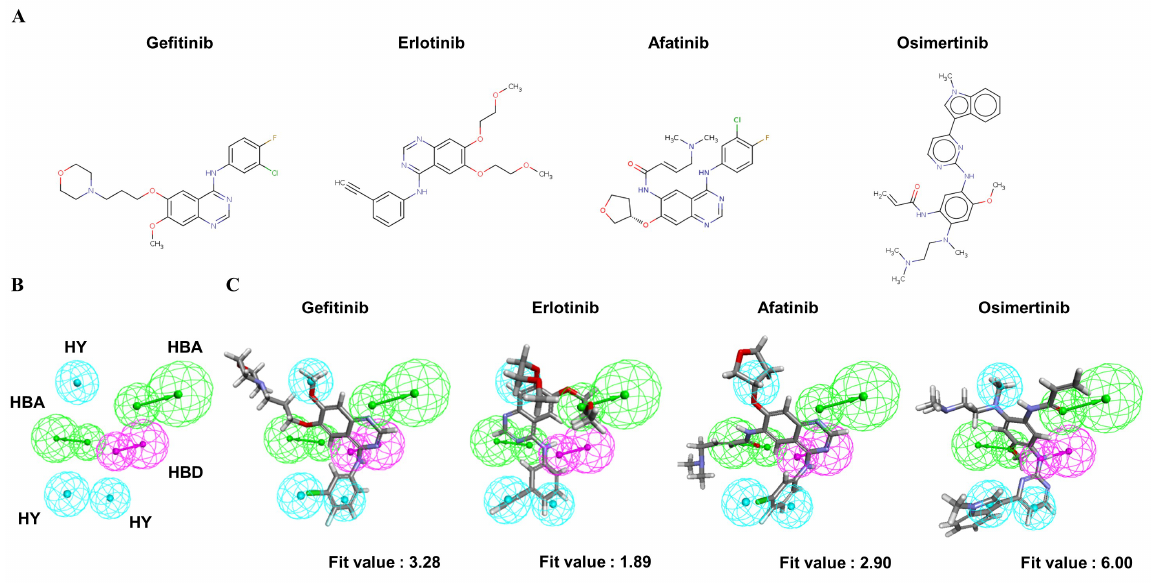
Figure 3. The common feature pharmacophore model of clinical EGFR inhibitors. ( A ) Structures of four clinically approved EGFR inhibitors. Gefitinib, erlotinib, and afatinib are 4-anilinoquinazoline derivatives. Osimertinib is a mono-anilino-pyrimidine derivative. ( B ) Pharmacophore features of the Pharm2 model: hydrogen bond acceptor (HBA, green), hydrogen bond donor (HBD, purple), and hydrophobic region (HY, blue). ( C ) Mapping of gefitinib (fit value = 3.28), erlotinib (fit value = 1.89), afatinib (fit value = 2.90), and osimertinib (fit value = 6.00) in the Pharm2